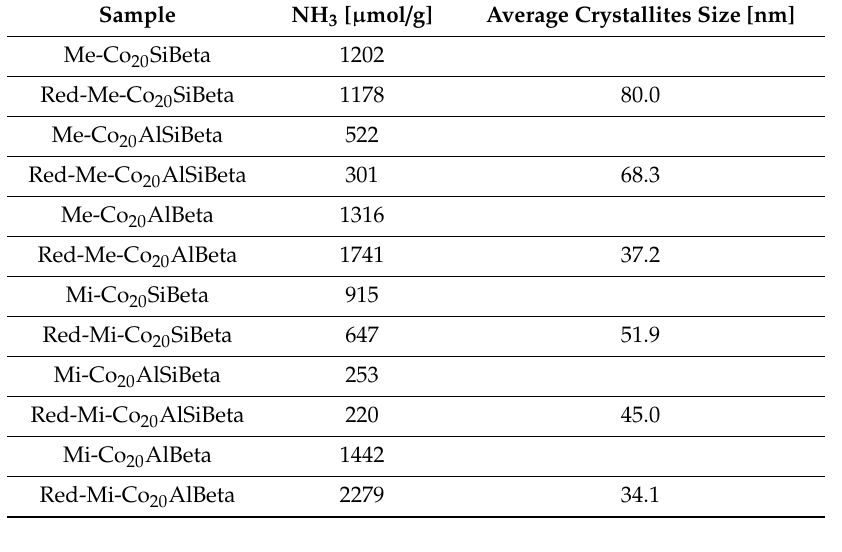
Table 2. The average crystallites size and amount of NH 3 adsorbed on Co-containing Beta zeolites.